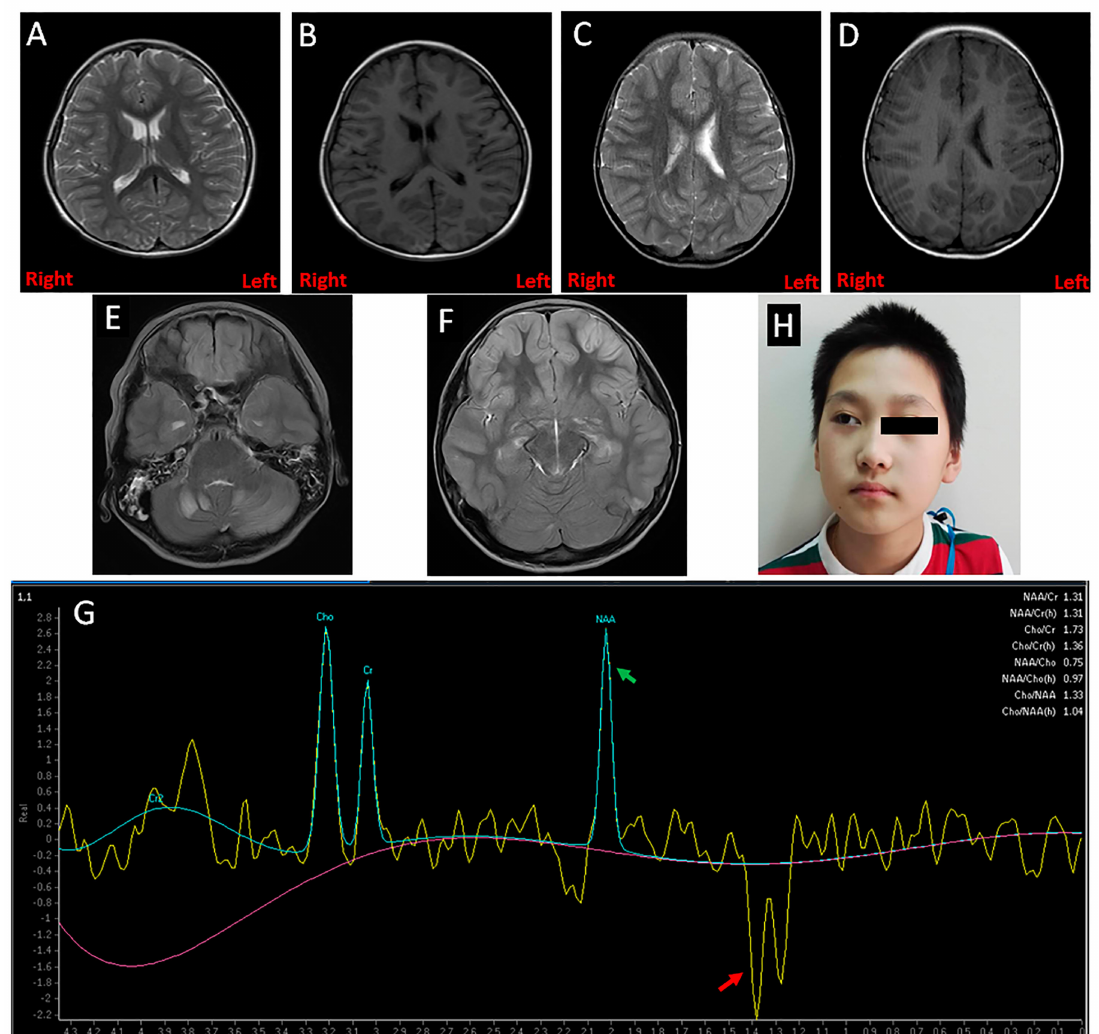
Figure 1. Clinical features of the patients. ( A , B ) Magnetic resonance imaging (MRI) showed a mildly enlarged bilateral ventricle in Case 1; ( C , D ) A mildly enlarged left ventricle was found in Case 2 by MRI; ( E , F ) Several parts of the brain (cerebellum, frontoparietal, basal ganglia, and thalamus) in Case 4 had symmetrical patchy abnormal signals; ( G ) Magnetic resonance spectroscopy (MRS) revealed the brain of Case 4 had an abnormal increased lactate peak and reduced N -acetyl aspartate (NAA) peak, which is marked by the red and green arrows, respectively; ( H ) The facial picture of Case 4 with a strabismic right